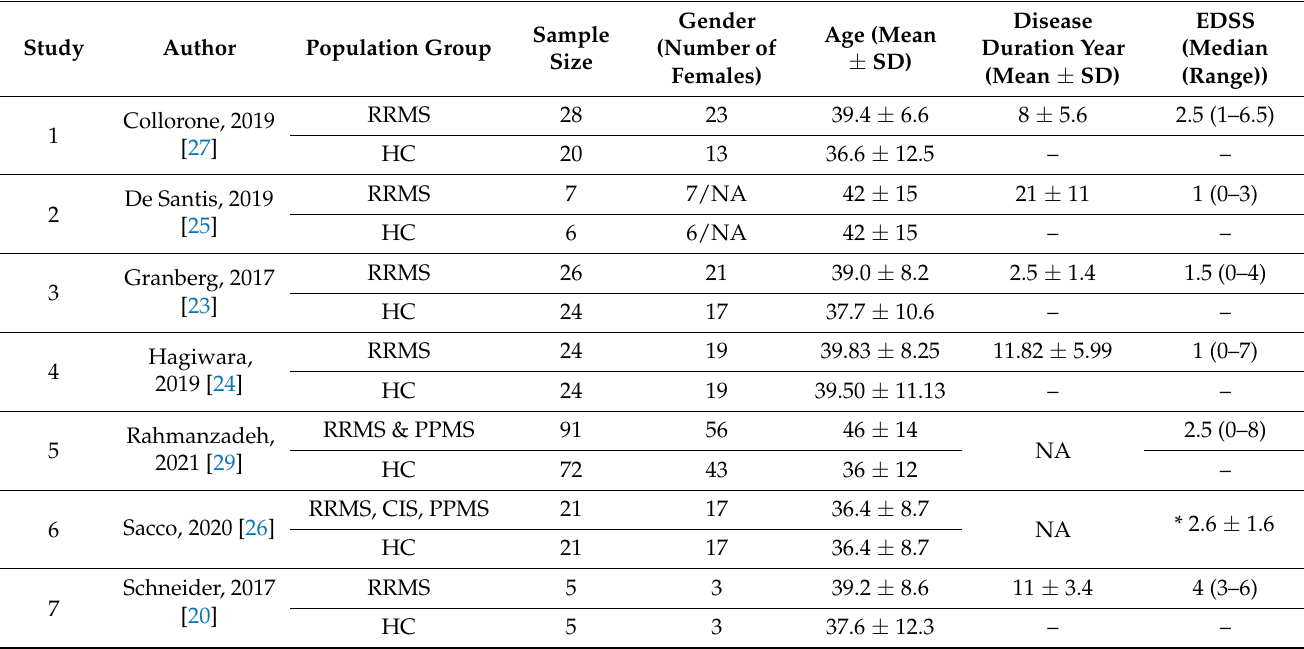
Table 1. Demographics and clinical characteristics of the included NODDI studies on MS. Abbreviations: NA = not available; HC = healthy controls; * = mean and standard deviation; – = not applicable; SD = standard deviation; RRMS = relapsing remitting multiple sclerosis; PPMS = primary progressive multiple sclerosis; and CIS = clinically isolated syndromes.